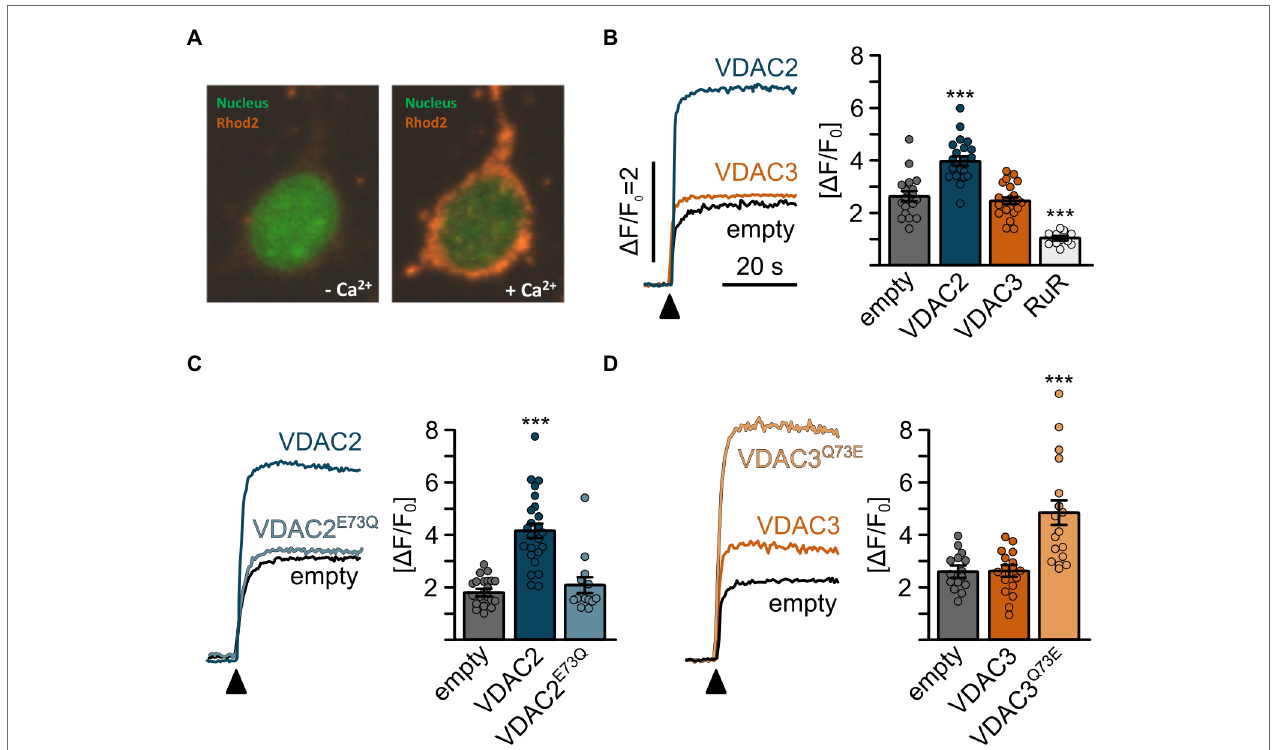
FIGURE 7 | Mitochondrial Ca 2+ uptake in HeLa cells is promoted by E73. (A) Representative confocal images of permeabilized HeLa cells loaded with Rhod2 after transiently transfection with VDAC expression constructs. Mitochondrial Rhod2 fluorescence is minimal at the basal state (left). Upon addition of Ca 2+ , the Rhod2 fluorescence rapidly concentrates in mitochondria (right). (B-D) Mitochondrial Ca 2+ uptake assays of HeLa cells transiently transfected with VDAC constructs; (B) mitochondrial Ca 2+ uptake was observed in empty vector transfected control cells (empty, ∆ F/F 0 = 2.64 ± 0.82, n = 18), which was significantly enhanced by overexpression of VDAC2 ( ∆ F/F 0 = 3.99 ± 0.80, n = 22) but not VDAC3 ( ∆ F/F 0 = 2.47 ± 0.61, n = 22) and significantly inhibited by ruthenium red ( ∆ F/ F 0 = 1.06 ± 0.23, n = 12). (C) While wild-type VDAC2 enhanced mitochondrial Ca 2+ uptake ( ∆ F/F 0 = 1.83 ± 0.52 for empty cells vs. ∆ F/F 0 = 4.18 ± 1.4 for VDAC2, n = 22 and 24, respectively), VDAC2 E73Q failed to induce this effect ( ∆ F/F 0 = 2.09 ± 1.15, n = 13). (D) Conversely, wild-type VDAC3 did not induce a significant increase in mitochondrial Ca 2+ uptake ( ∆ F/F 0 = 2.63 ± 0.70 for empty cells vs. ∆ F/F 0 = 2.59 ± 0.81 for VDAC3, n = 15 and 18, respectively); however, VDAC3 Q73E significantly increased mitochondrial Ca 2+ uptake to ∆ F/F 0 = 4.85 ± 1.99 ( n =